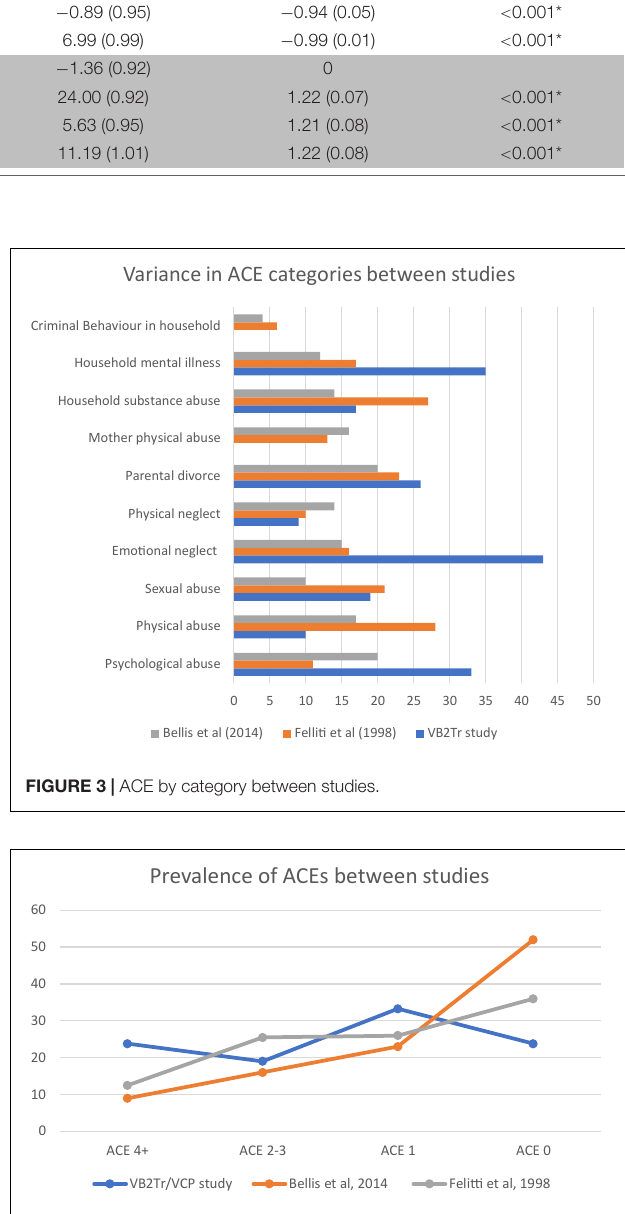
FIGURE 4 | Prevalence of ACE scores between the three groups: VB2Tr.